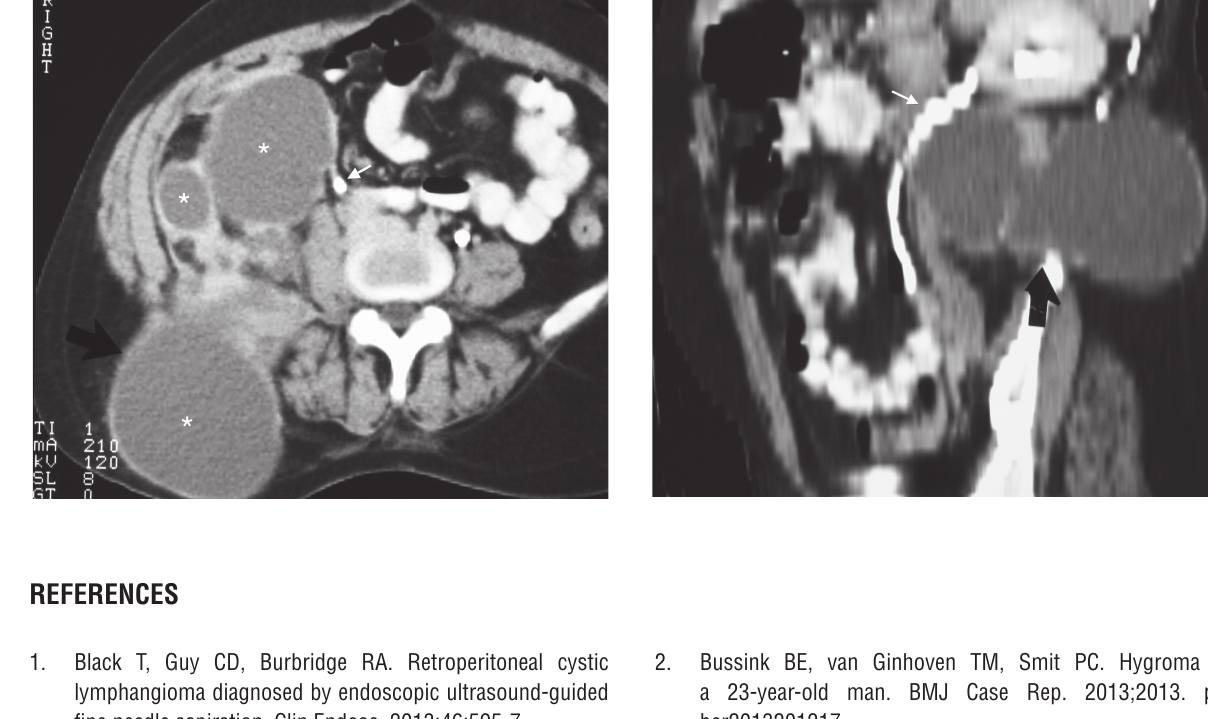
lymphangioma diagnosed by endoscopic ultrasound-guided fine needle aspiration. Clin Endosc. 2013;46:595-7.